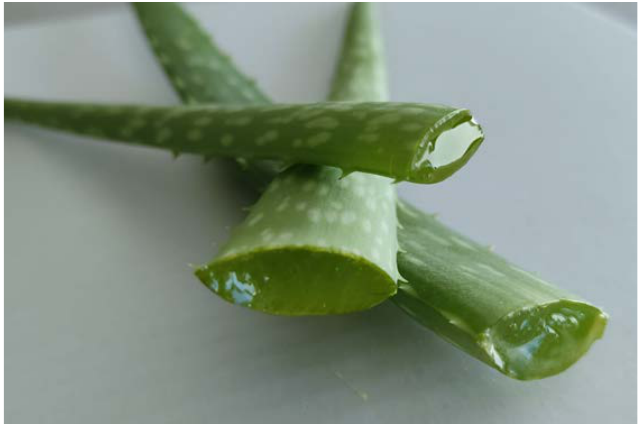
Figure 3. Aloe vera .